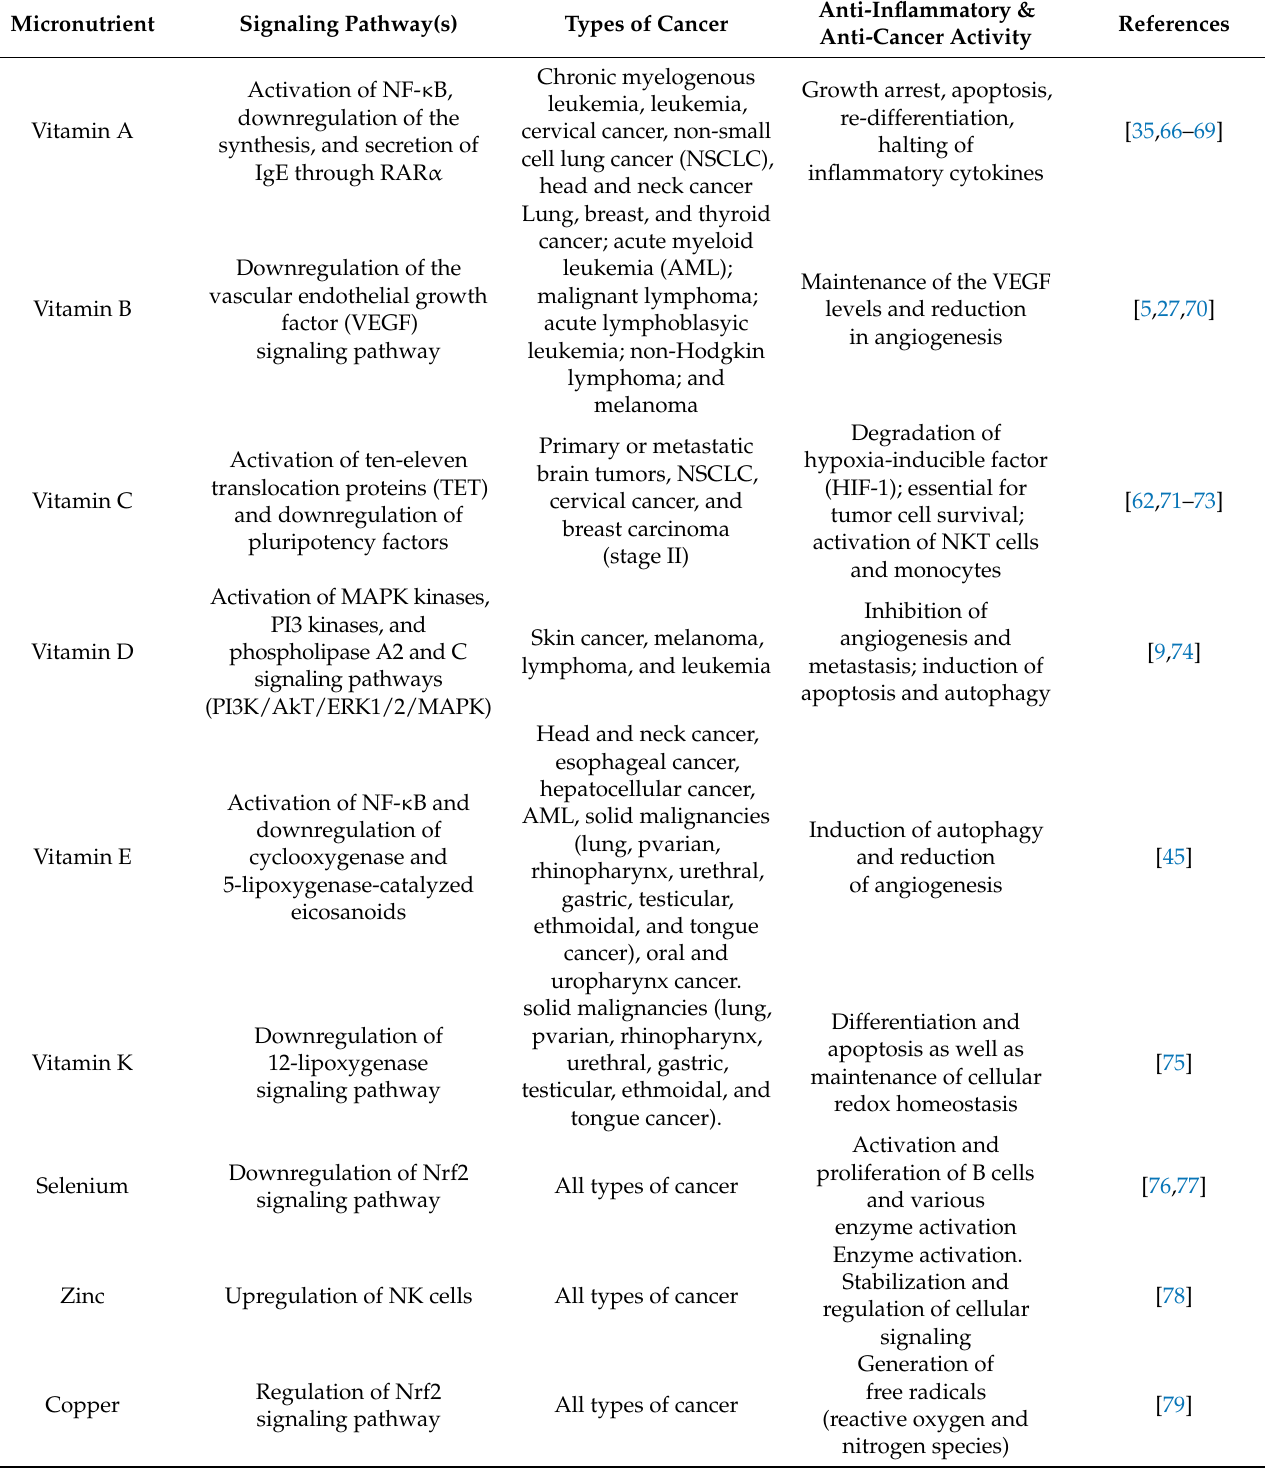
Table 2. Anti-inflammatory and anticancer activities of micronutrients through regulation of specific cell signaling